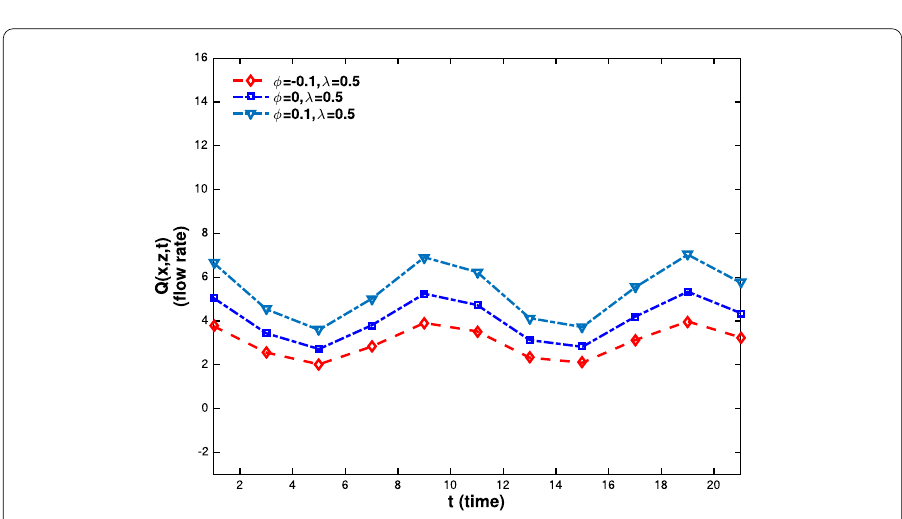
Figure 27 Flow rate vs time for φ = –0.1,0,0.1 at z = 28, τ y = 0.4, K = 1.6, λ =